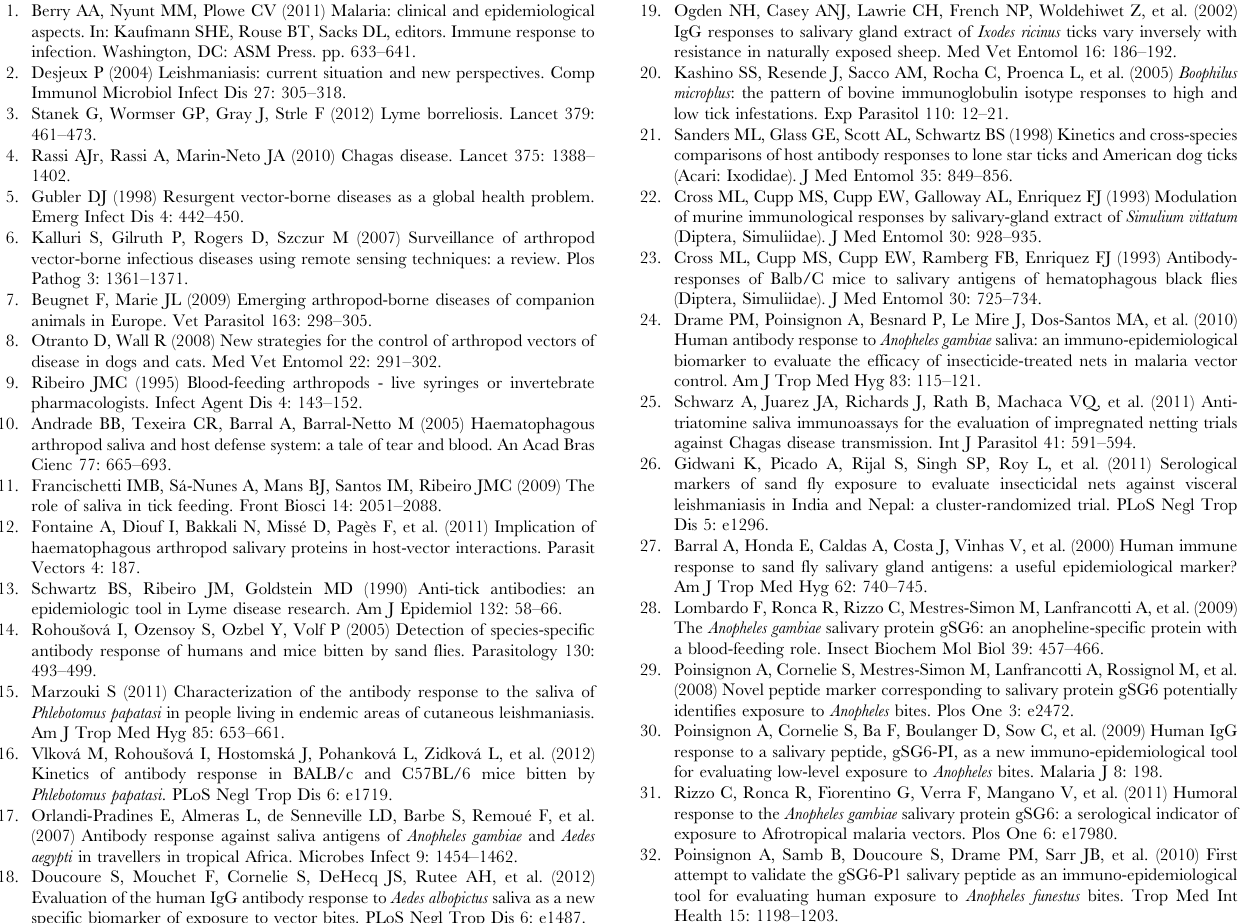
instar nymphs (5 th instar, A) and adults (females and males, E) of Chilean T. infestans were isoelectrically focused in the nonlinear pH range of 3–11. Black circles indicate nymphal (A) or adult (E) specific salivary proteins. In order to improve the protein separation, saliva of nymphs (B) and adults (F) were isoelectrically focused in the nonlinear pH range of 3–5.6 and blotted onto nitrocellulose. Comparing IgG (C, G) and IgM antibody reactions was recognized by IgG and IgM antibodies of guinea pig serum from the 5 th week of exposure to the Chilean T. infestans strain.